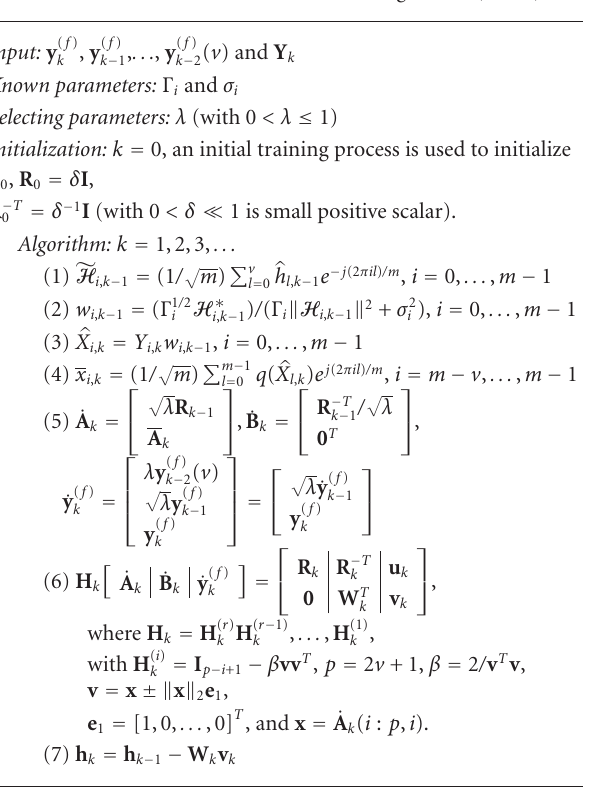
Table 2: CP-based Extended SBHT-RLS algorithm